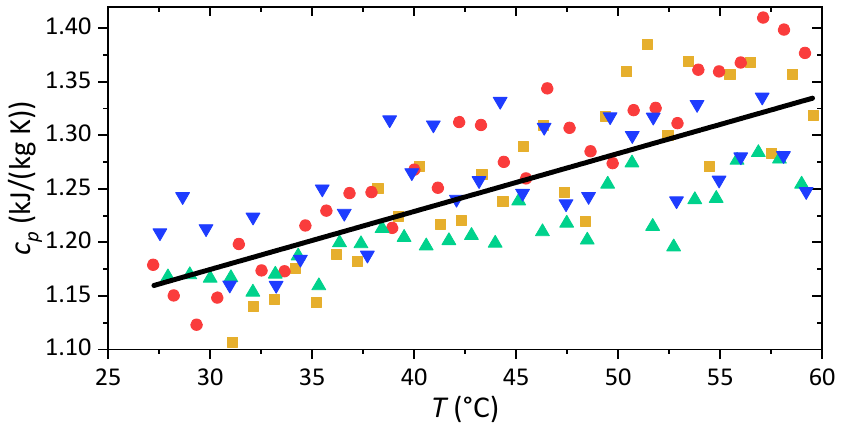
Figure 6. Specific heat capacity as a function of temperature in the range between 28 °C and 60 °C from four measurements (different symbols) with linear fit (black line).